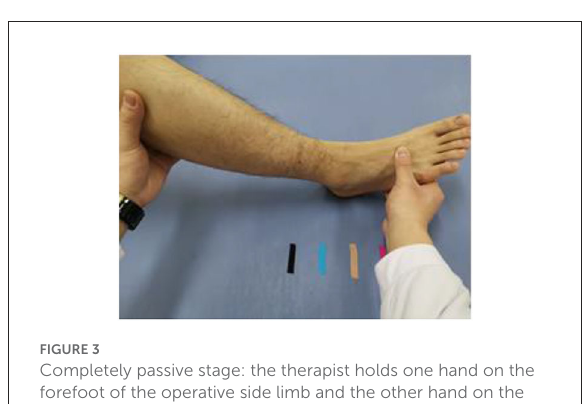
FIGURE2 Different color sticky patches were used to fix the marker, (A) : each sticky patch is 10cm apart, (B) : each sticky patch is 5cm apart.